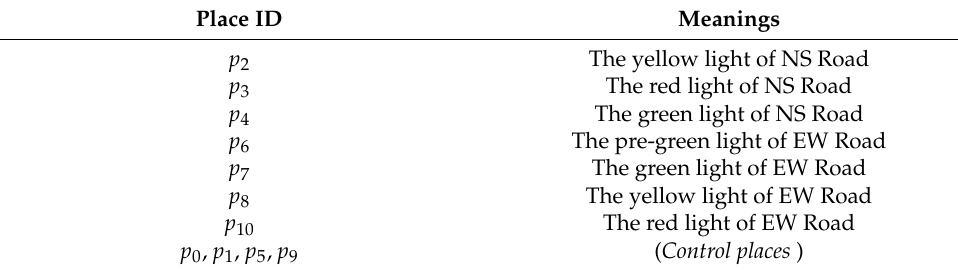
Table 2. Places and their